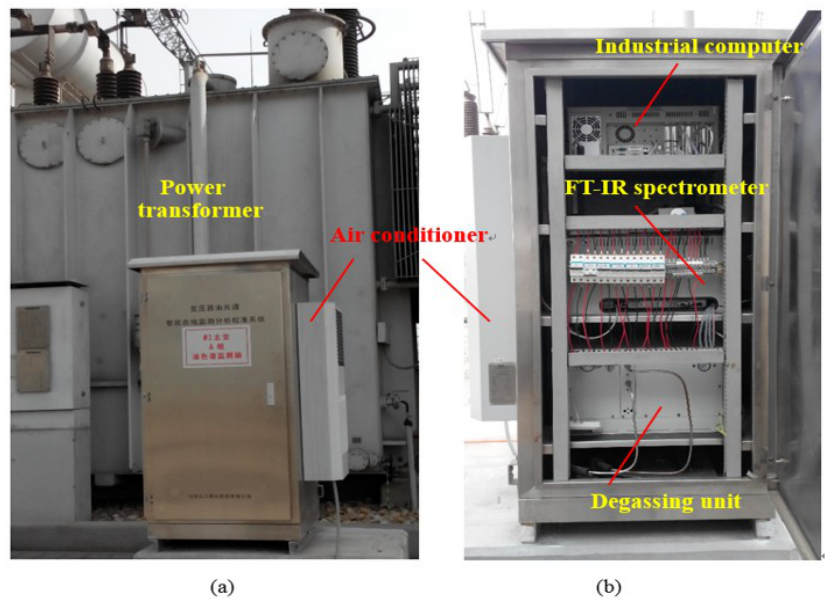
Figure 1. Schematic diagram of oil-dissolved gas analyzer.